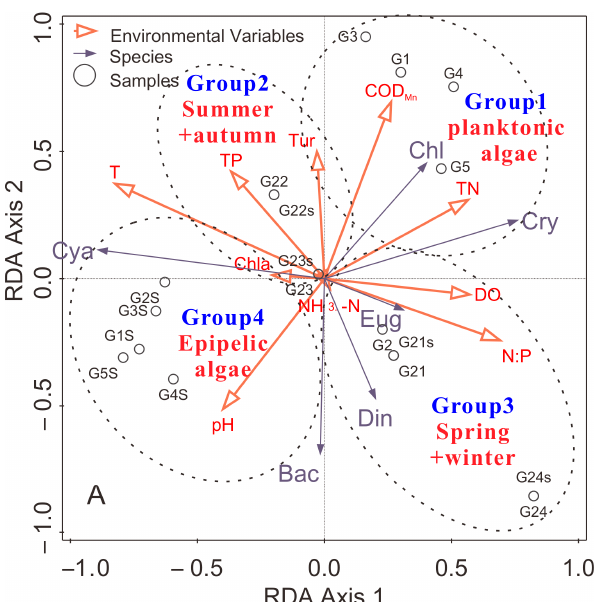
Figure 5. RDA ordination between the abundance of algae and environmental factors. Note: the G1–G5 refer to the planktic algae samples in different sites, the G21–G24 refer to the planktic algae samples in G2 site and G21 is spring sample, G22 is summer sample, G23 is autumn sample, and G24 is winter sample. The G1s–G5s refer to the epipelic algae samples in different sites, the G21s–G24s refer to the epipelic algae samples in G2 site and G21s is spring sample, G22s is summer sample, G23s is autumn sample, and G24s is winter sample. Cya : Cyanobacteria; Din : Dinophyta; Bac : Bacillariophyceae; Chl : Chlorophyta; Eug : Euglenozoa.